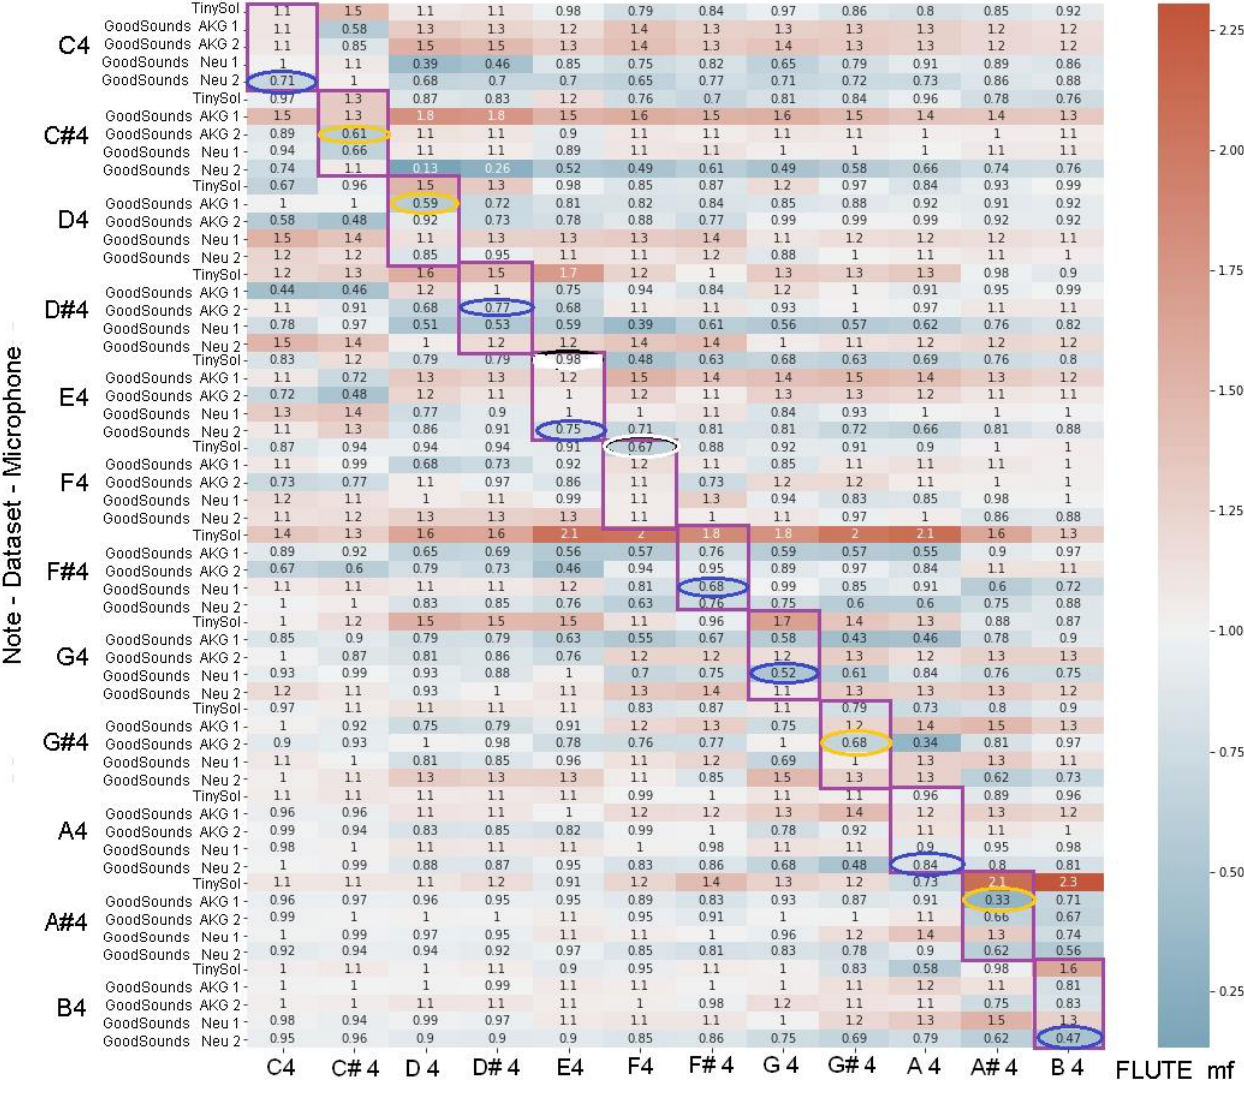
Table 1. Average distance in the timbral space of the sounds A#4 and B4 for Flute and Clarinet. ClBb A#4